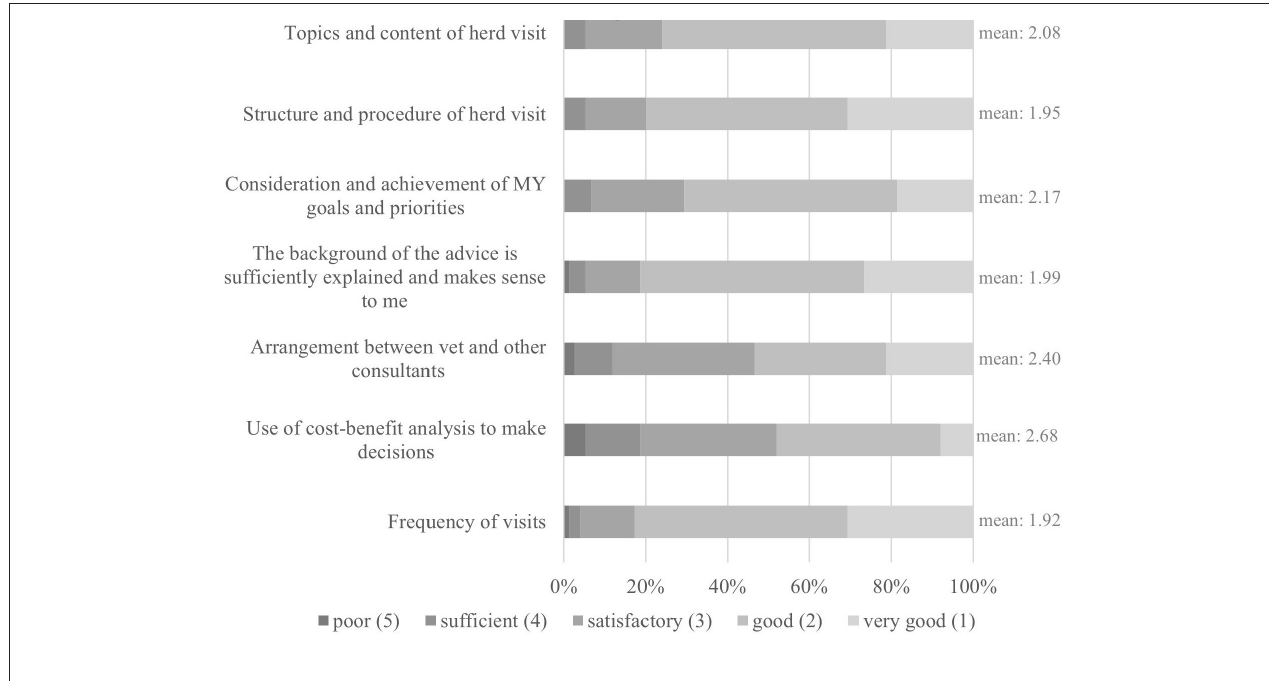
FIGURE 4 | Bar chart: Quality of current